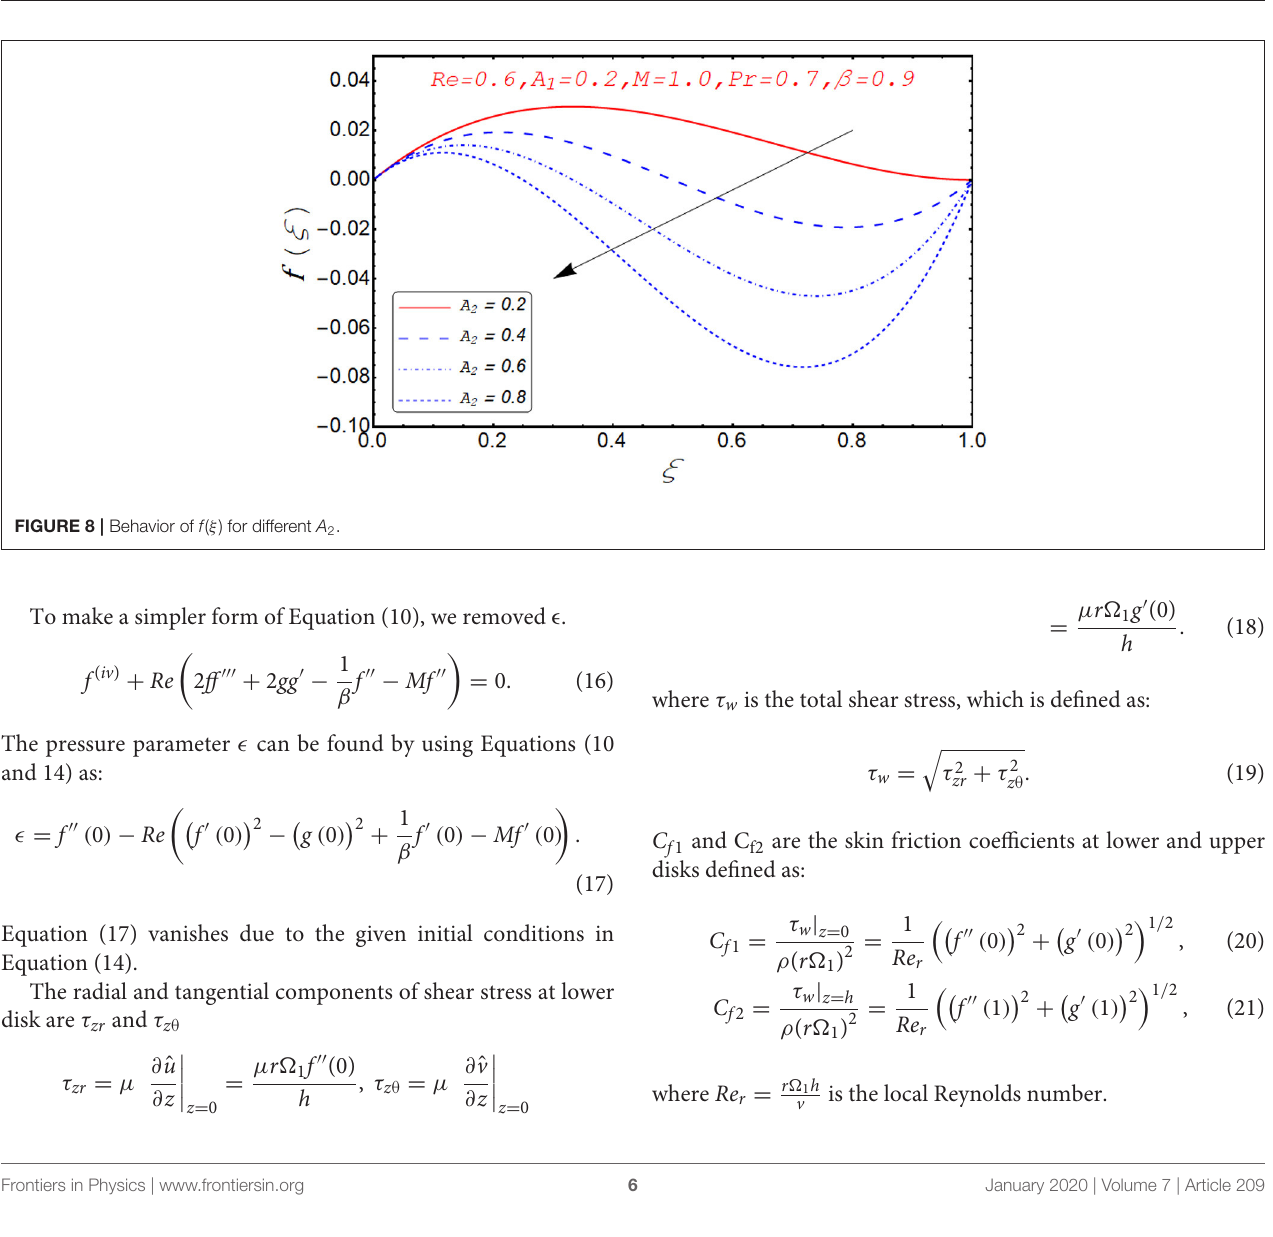
FIGURE 7 | Behavior of f ′ ( ξ ) for different A 2 .